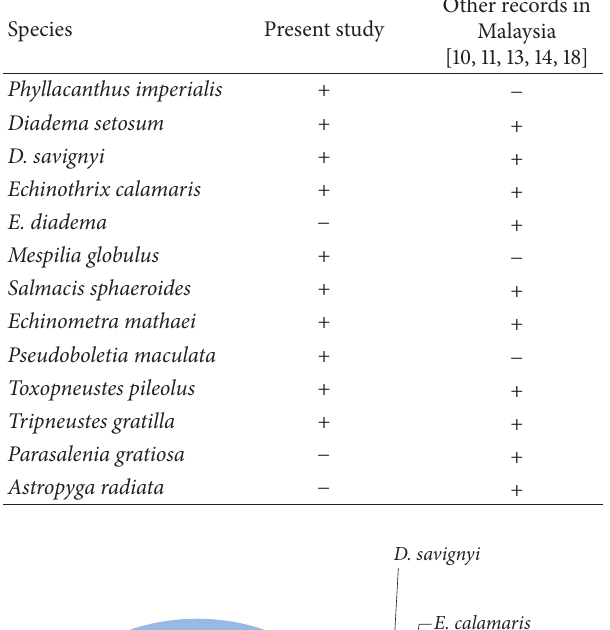
Table 3: Comparison of species lists between the present study and other records in Malaysia. (+): present and ( − ): absent. Species